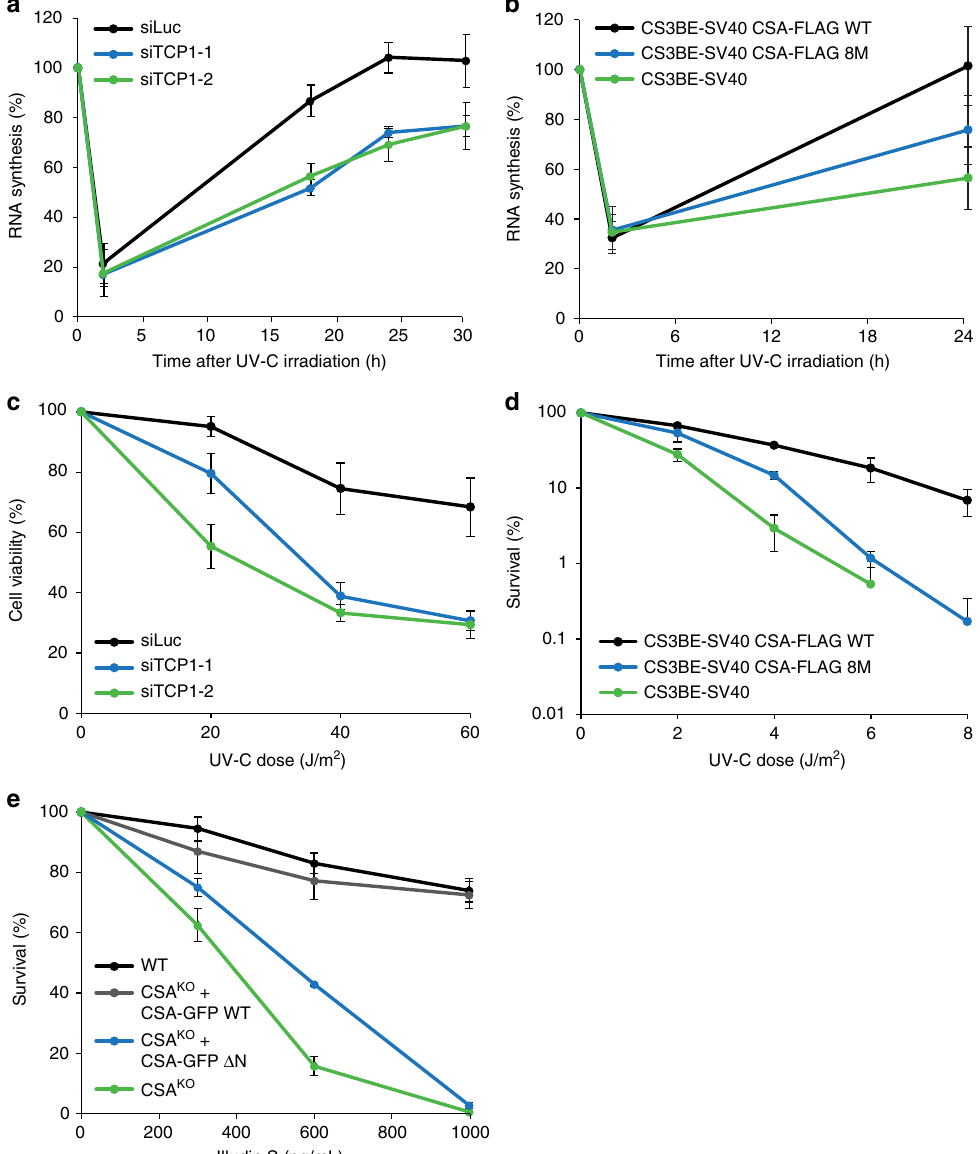
Fig. 6 Loss of TRiC reduces RRS and protection against UV damage. a TCP1 loss reduces RNA synthesis recovery following UV-C irradiation. VH10-hTert cells were transfected with the indicated siRNAs and UV-C irradiated (10 J/m 2 ). RNA synthesis was measured by means of EU incorporation at the indicated time points after UV. RNA synthesis levels were normalized to those in non-irradiated cells, which were set to 100%. Data represent the mean ± SEM of four independent experiments. b Expression of CSA-FLAG 8M shows reduced RNA synthesis recovery as compared to expression of CSA-FLAG WT. As in a , except that CS3BE-SV40 cells expressing CSA-FLAG WT or CSA-FLAG 8M were used. Data represent the mean ± SEM of four independent experiments. c TCP1 loss renders cells hypersensitive to UV damage. VH10-hTert cells were transfected with the indicated siRNAs, UV-C irradiated at the indicated doses and 72 h later assayed for viability using alamarBlue ® . Data represent mean ± SEM of four independent experiments. d Expression of CSA- FLAG 8M in CS3BE-SV40 cells fails to rescue UV-sensitivity. CS3BE-SV40 cells stably expressing CSA-FLAG WT or CSA-FLAG 8M were UV-C irradiated and clonogenic survival was measured. Data represent mean ± SEM of three independent experiments. e CSA WT, but not CSA Δ N, complements the Illudin S sensitivity of CSA knockout (KO) U2OS cells. The indicated cells were treated with different concentrations of Illudin S and clonogenic survival was determined. Data represent mean ± SEM of three independent